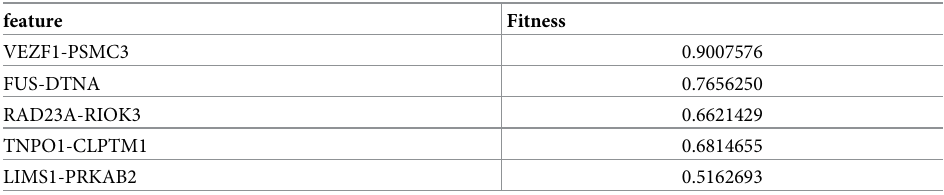
Table 1. significant gene